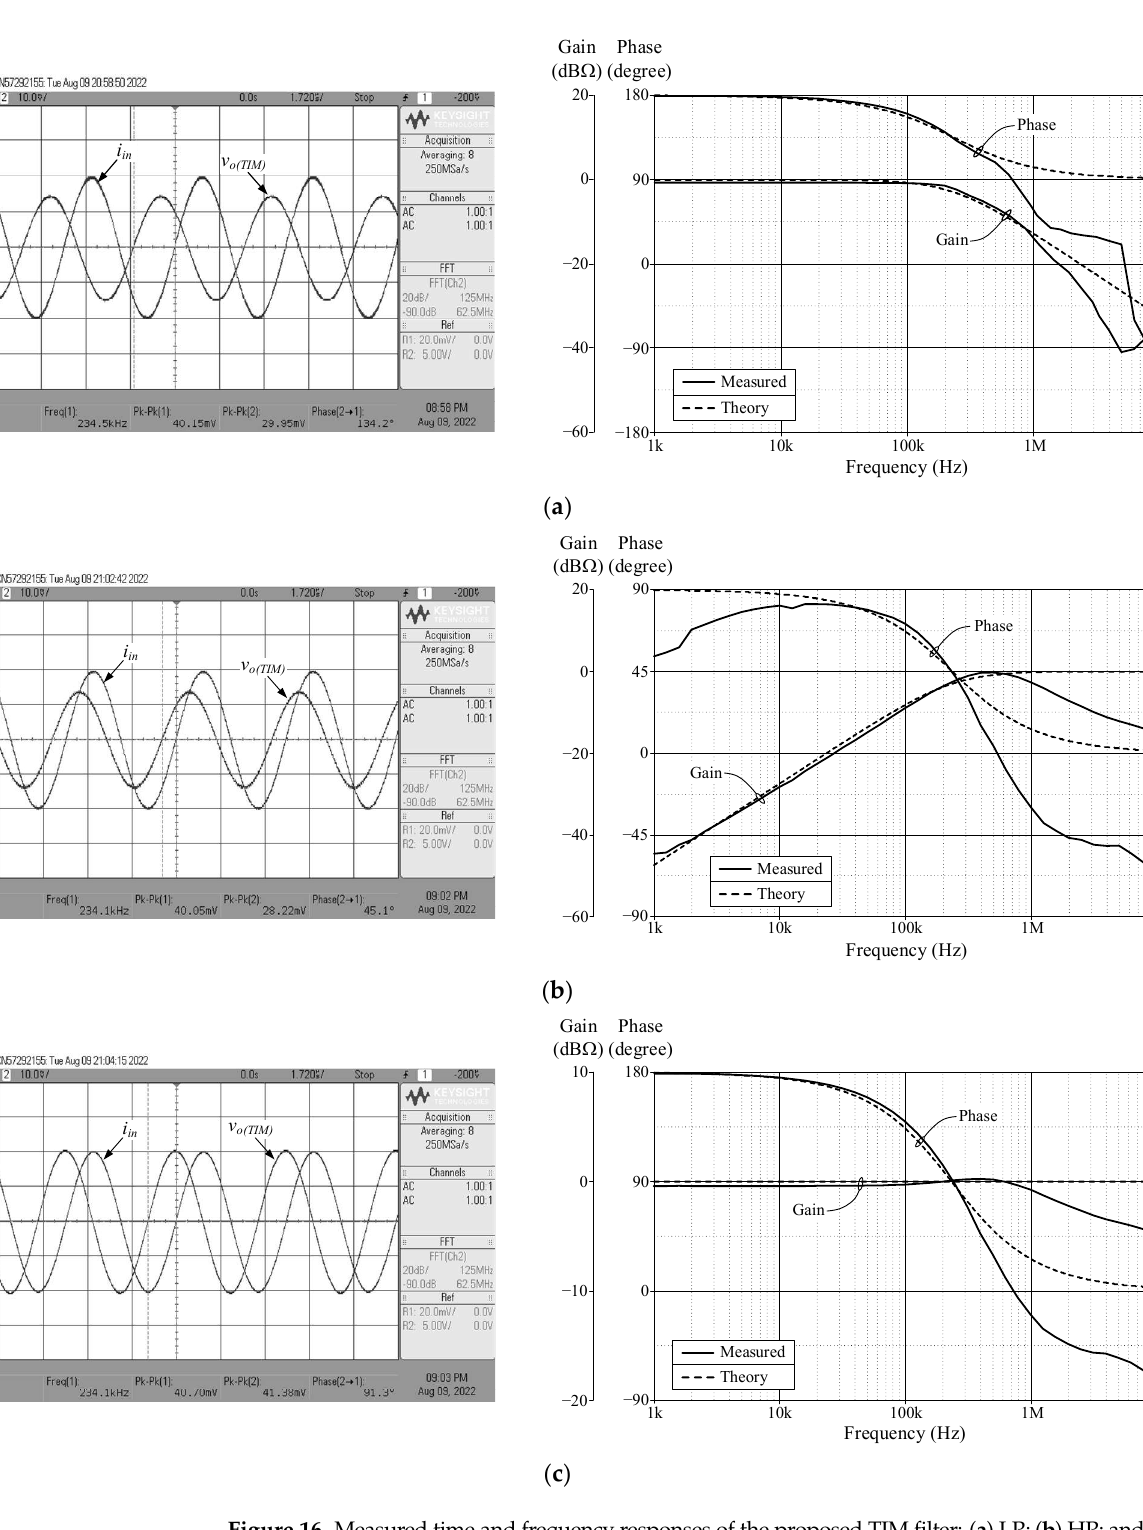
Figure 16. Measured time and frequency responses of the proposed TIM filter: ( a ) LP; ( b ) HP; and ( c ) AP. Table 6. Measured f p and percentage errors of the proposed filter in Figure 2.